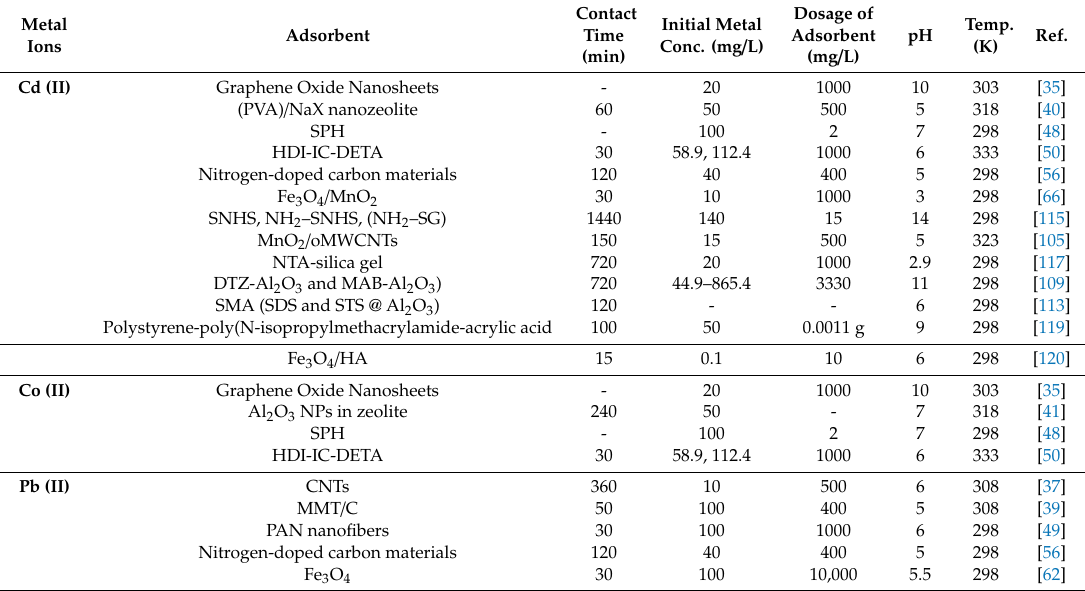
Table 1. Nanomaterials for heavy metals removal from water. Metal